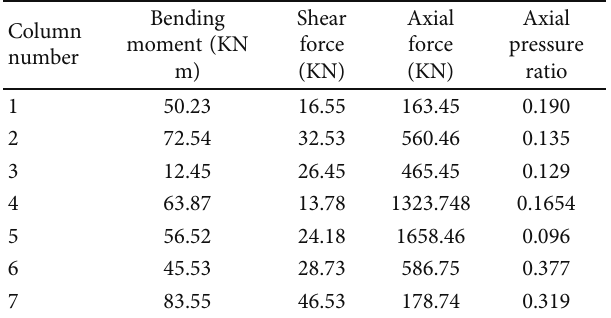
Table 2: Internal forces of conventional design method columns. Column number